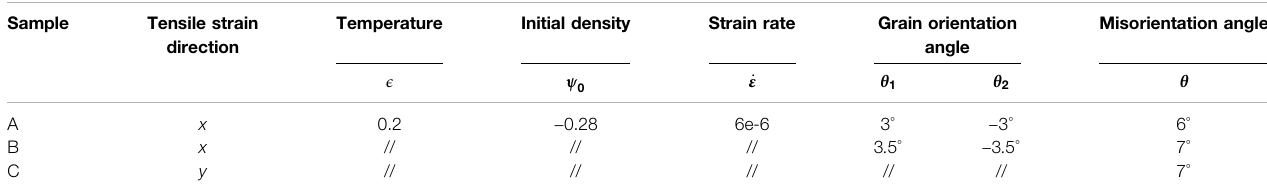
TABLE 1 | Parameters for sample